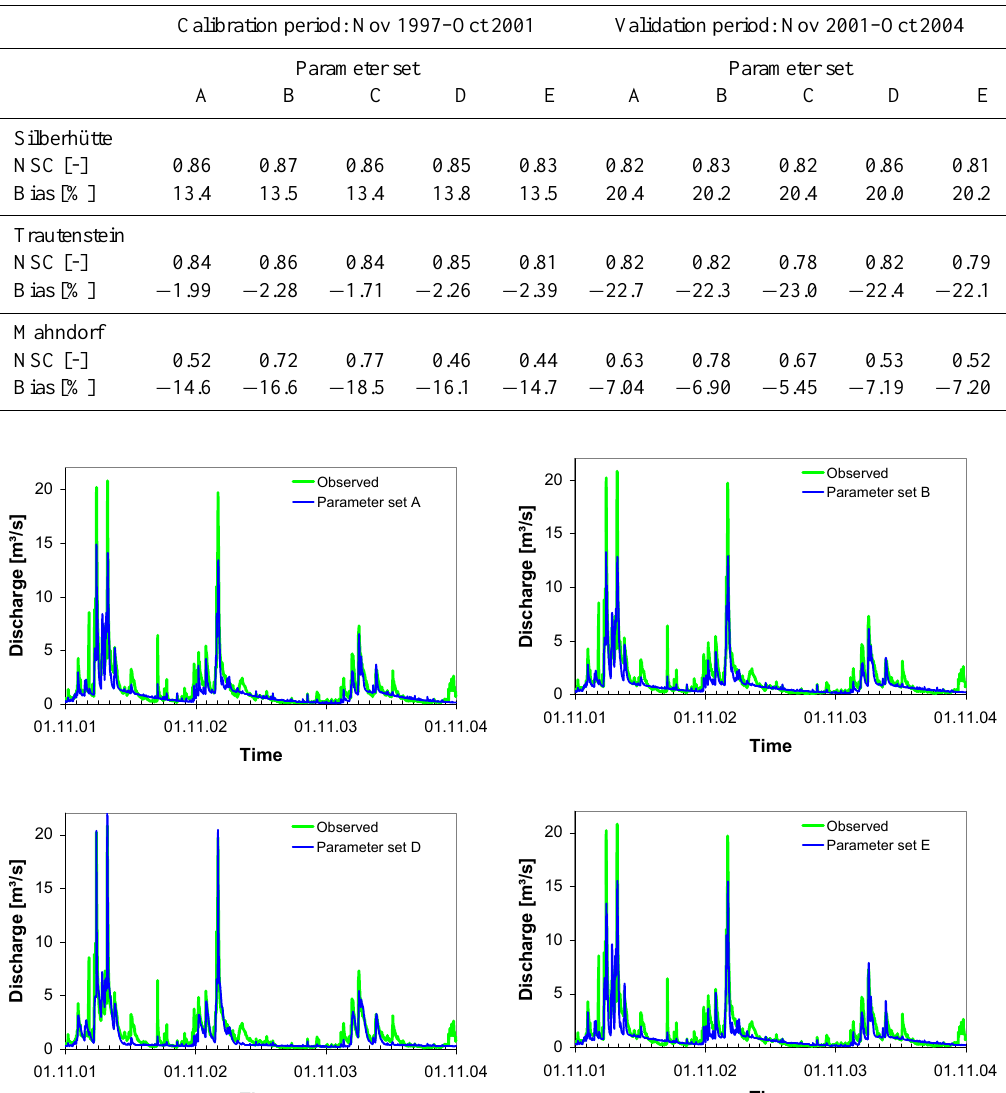
Figure 8: Simulated hydrographs using four different parameter sets A, B, D and E based on observed hourly precipitation for the validation period from November 2001 to October 2004